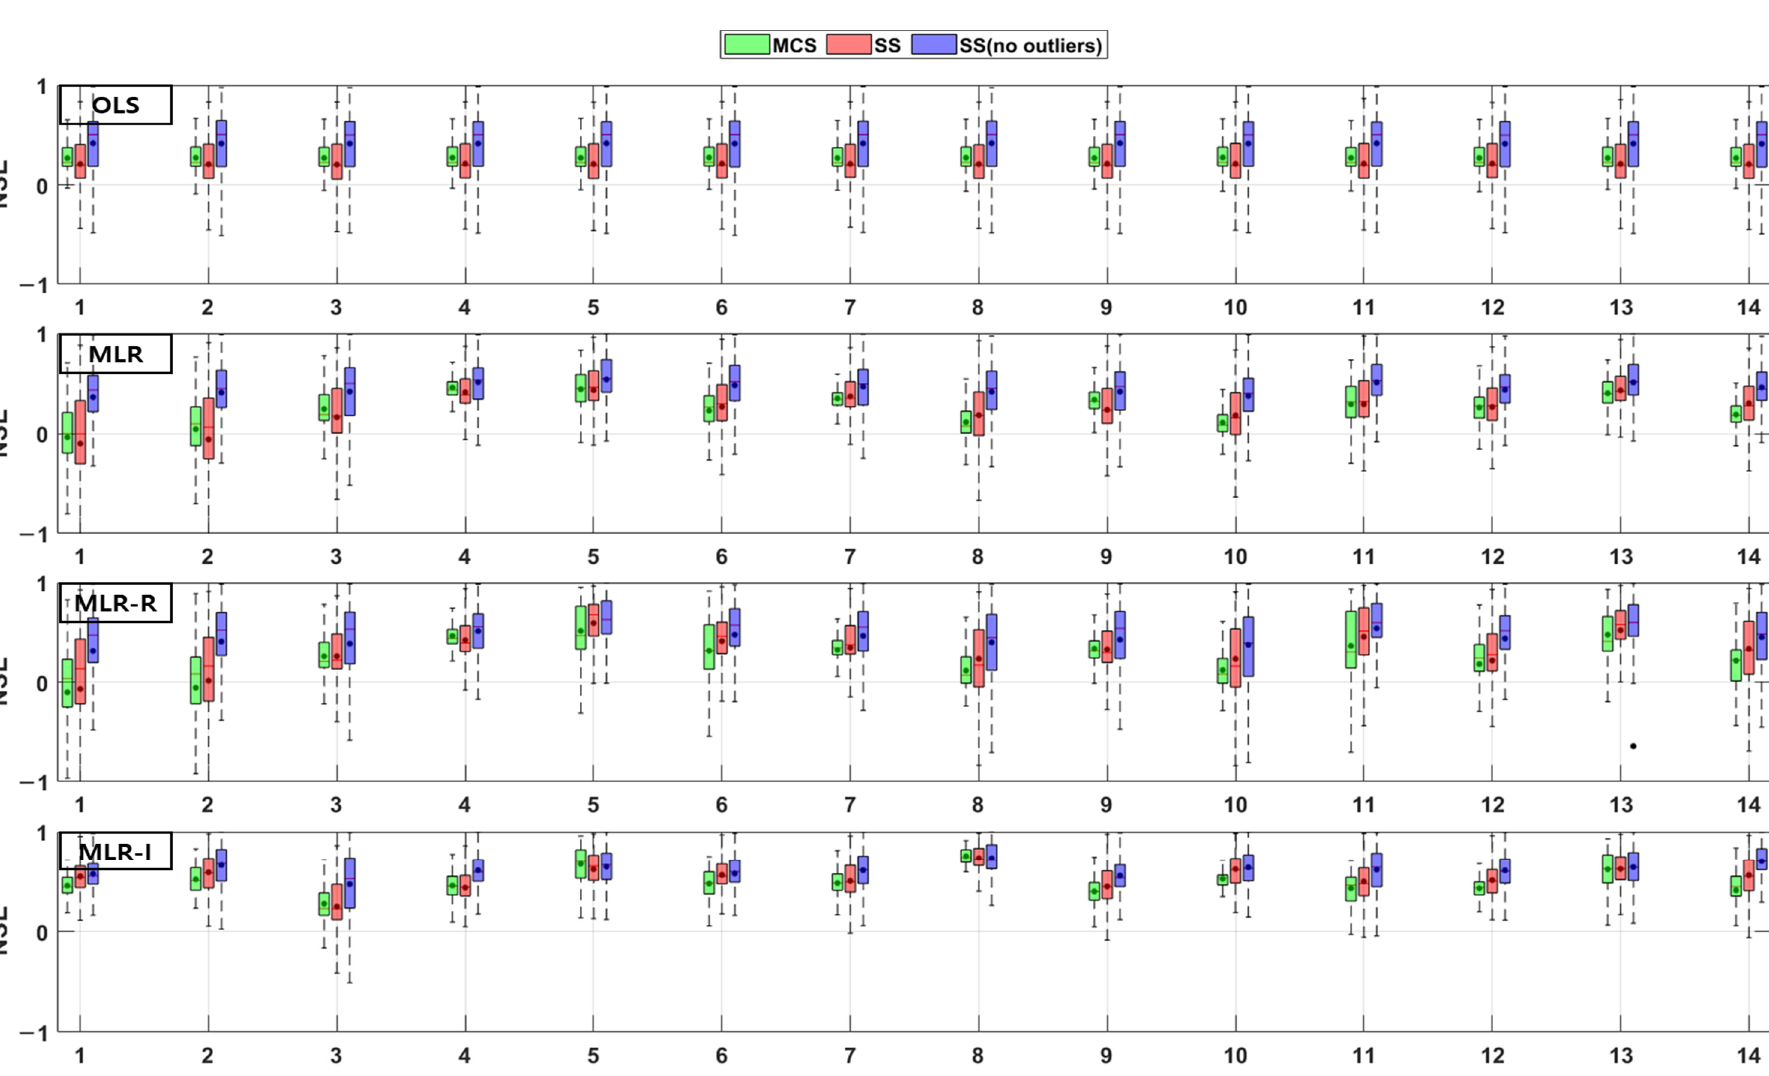
Figure 15. Error analysis (NSE) results of TP removal in retention ponds.